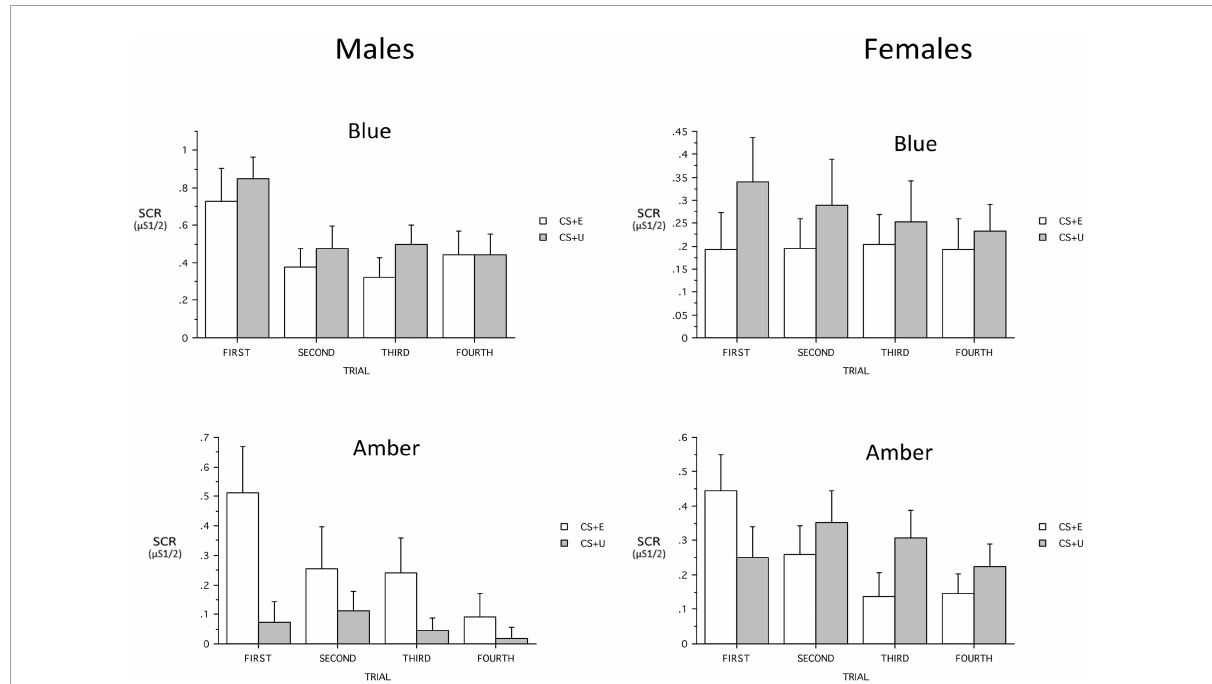
FIGURE6 Sex × light color interactions on skin conductance responses (SCR) across trials for the blue light treatment-BLT (top) and amber light placebo treatment-ALT (bottom) for the extinguished (CS + E) versus unextinguished (CS + U). µ S, microSiemens. Error bars represent standard error of the mean. Error bars represent standard error of the mean and Y-axis scales are